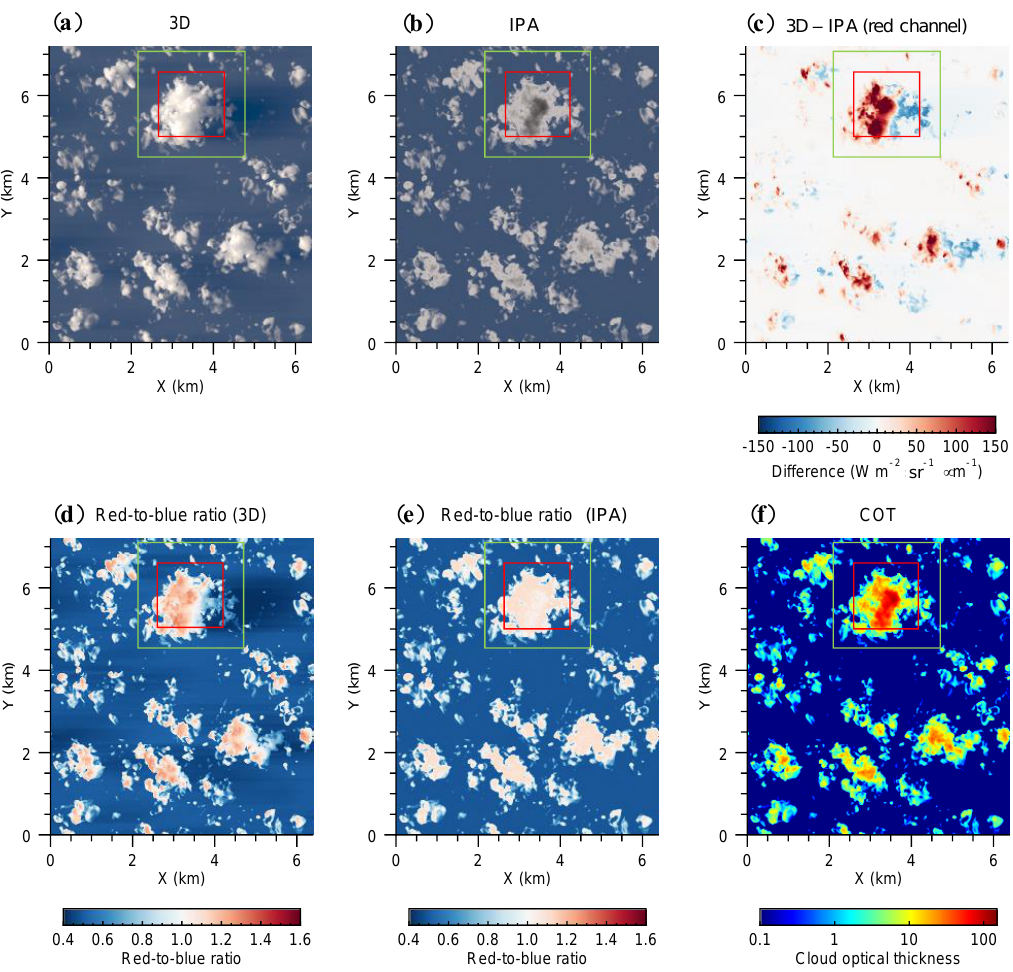
Figure 2. Examples of the spatial distributions of the zenith-viewing transmitted radiances at the ground, as follows: ( a ) true-color image composed of mean spectral radiances in the red, green, and blue (RGB) channels in the standard RGB (sRGB) color space defined by International Electrotechnical Commission, computed by three-dimensional (3D) radiative transfer; ( b ) the same as ( a ), but for radiances computed using the independent pixel approximation (IPA); ( c ) differences in the mean spectral radiance in the red channel between the 3D and IPA calculations; ( d , e ) red-to-blue ratio (RBR) of 3D and IPA, respectively; ( f ) COT. The sun is located in the left of the images, with a solar zenith angle of 60 ◦ . The regions framed by red squares correspond to the examples of image patches analyzed in detail in this study, and the regions framed by green squares correspond to pixels of the input and output for the convolutional neural network (CNN).